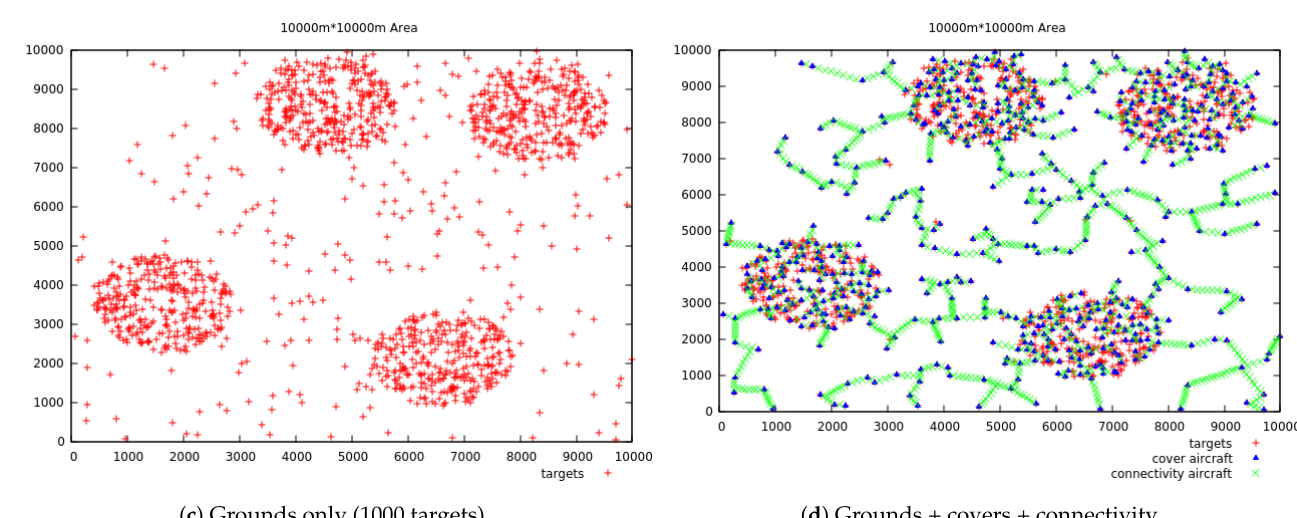
Figure 11. Results on the dataset with large gaps between connected